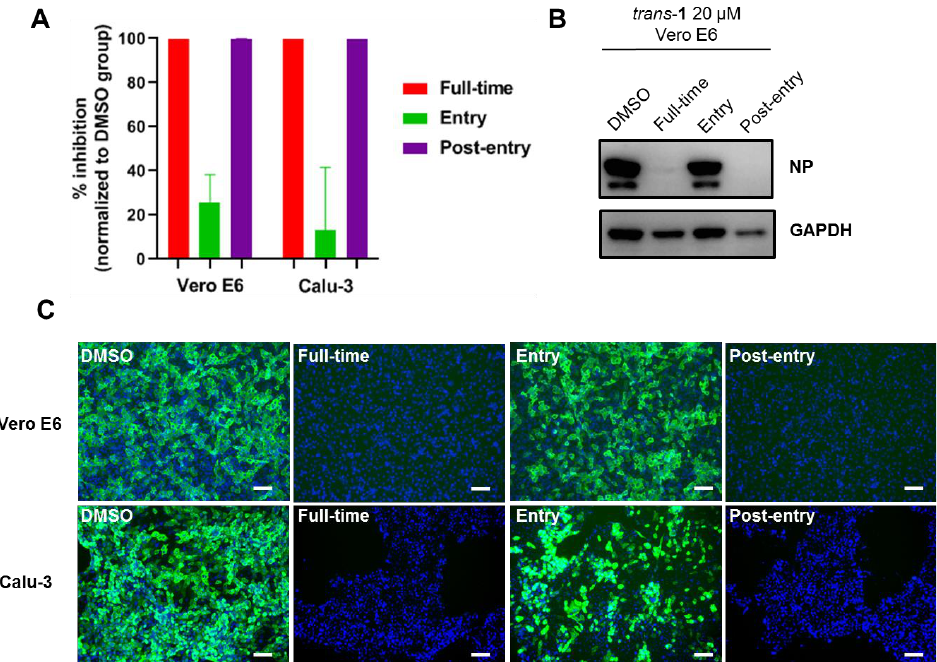
Figure 5. Compound trans - 1 inhibits SARS-CoV-2 replication at the post-entry stage. A time of addition assay was performed to determine the point where trans - 1 inhibits viral infection. For the “Entry” treatment, the Vero E6 or Calu-3 cells were pre-incubated with trans - 1 (20 μM) containing a medium for 1 h and infected with SARS-CoV-2 (B.1.617.2) at an MOI of 0.05 for 1 h. Afterwards, the supernatant was removed, and the cells were washed with PBS and incubated with trans - 1 -free medium. For the “post - entry” treatment, a trans - 1 containing medium was only added after viral infection for 1 h. For the “full - time” treatment, trans - 1 was constantly present. Three kinds of samples were collected at the end of the experiment (24 h p.i. for Vero E6; 48 h p.i. for Calu-3): the supernatant was harvested for the quantification of the virus yield and the calculation of the inhibition rate ( A ); infected cells were lysed with 1 × SDS-PAGE loading buffer and analyzed for the NP expression via Western blotting ( B ); infected cells were fixed with 4% PFA, and immunofluorescence assay was performed to show the viral NP positive cells ( C ). The scale bar is 100 μm .